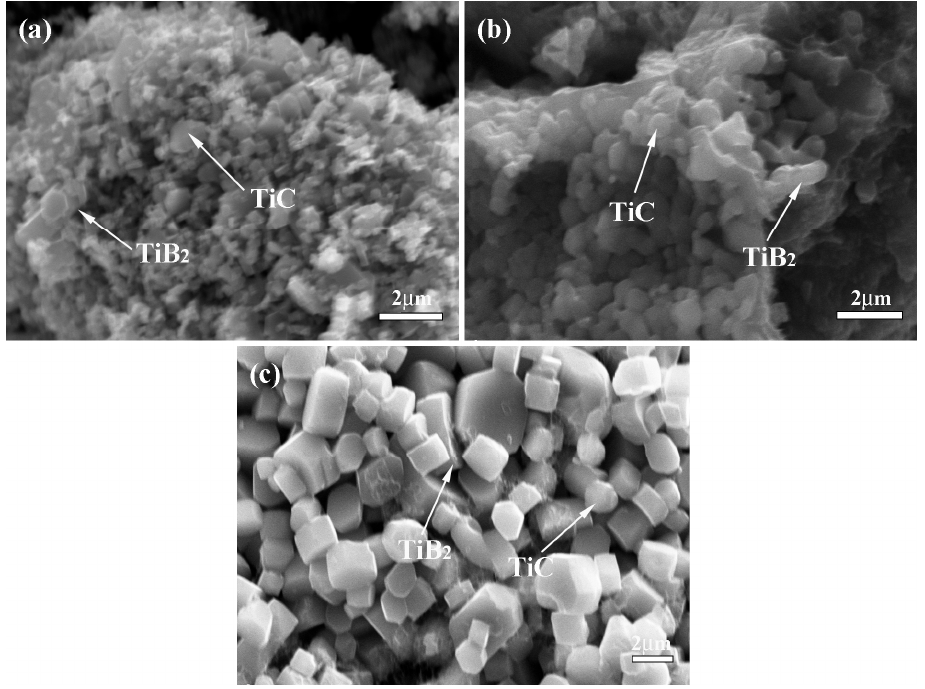
Figure 4. Fracture morphology of bionic layered composite ( a ) outer layer ( b ) middle layer ( c ) inner layer.